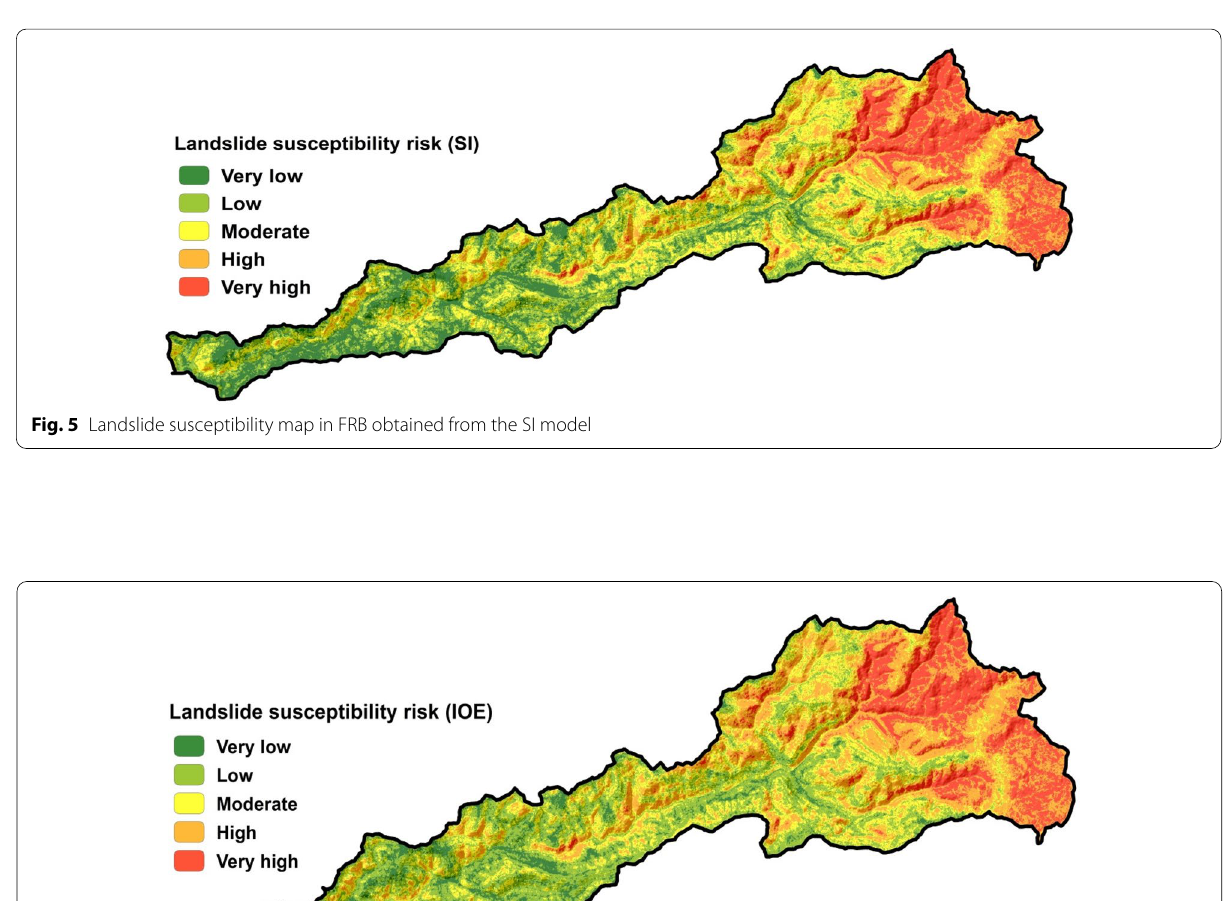
5.0010.0015.0020.0025.0030.0035.00 0.00